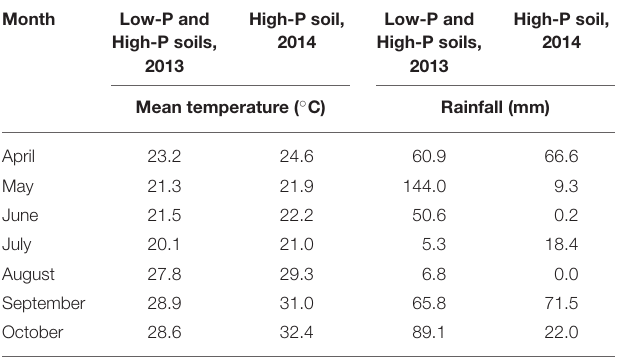
TABLE 1 | Climatic conditions at experimental sites in 2013 and